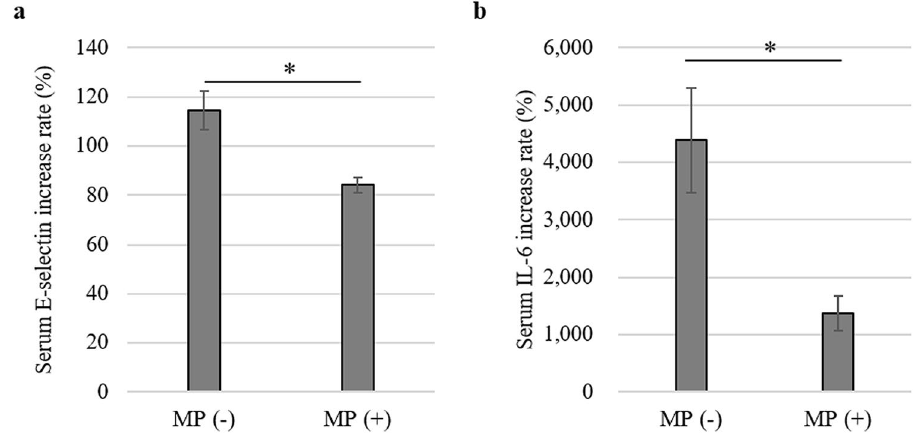
Figure 6. Effect of MP on postoperative serum molecular levels in human clinical samples. The percent increases from preoperative to postoperative samples of serum E-selectin ( a ) and IL-6 ( b ) levels are indicated. Data are means ± standard error (n = 17 for non-treated group and n = 15 for MP-treated group); * P <